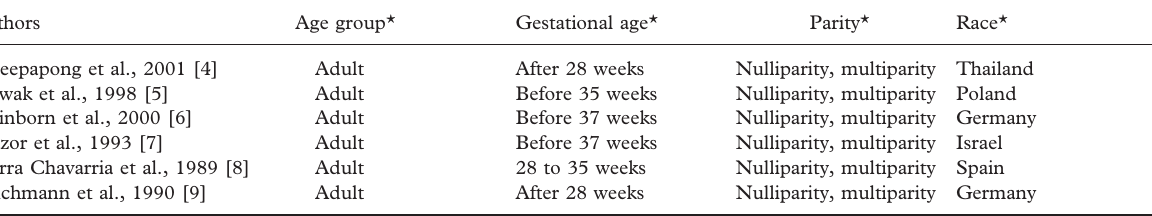
CRP, C-reactive protein; *these parameters have been shown not to affect the prevalence of disease.